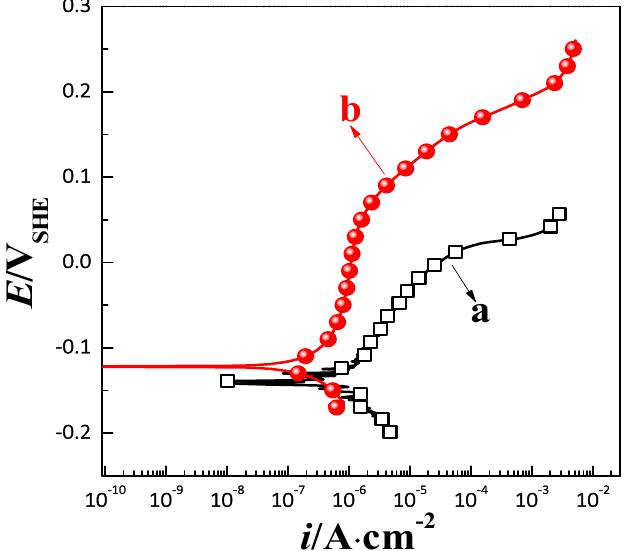
Figure 9. Potentiometric polarization curves of the Ni–W–P alloy coating obtained by ( a ) the orthogonal experimental design test and ( b ) the response surface method.